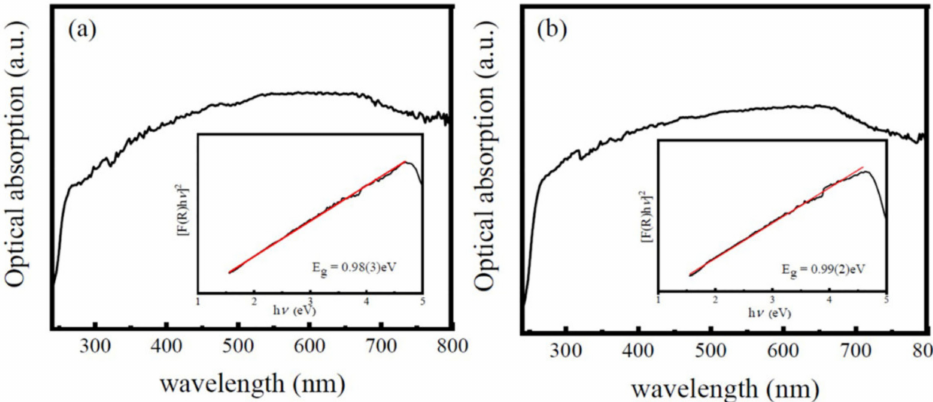
Figure 9. (Optical absorption spectra of ( a ) LNMO NPs and ( b ) NRs, and the insets are the corre- sponding Tauc plots of [ F ( R ) × h ν )] 2 versus photon energy h ν